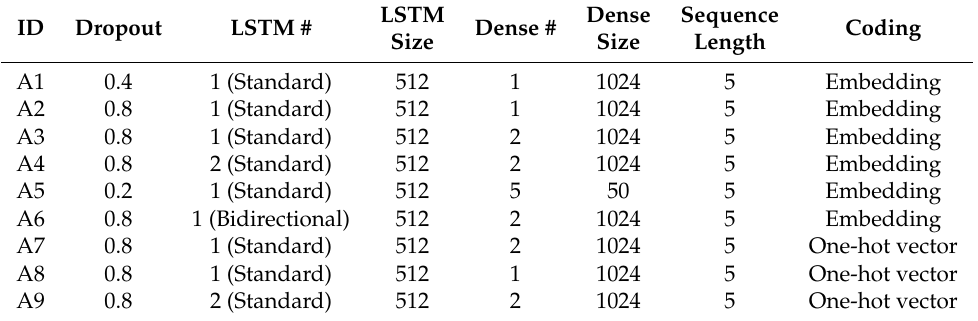
Table 1. Architecture experiments. Dropout is the value of the dropout regularizations. LSTM No. is the number of long short-term memory network (LSTM) layers in the architecture. LSTM size is the size of the LSTM layers. Dense No. is the number of fully connected layers with a rectified linear unit (ReLU) activation (all the architectures have a final fully connected layer with a softmax activation). Dense size is the size of the fully connected layers with a ReLU activation. Sequence length is the length of the input action sequence. Coding is the codifying strategy used for the actions, either embeddings or a one-hot